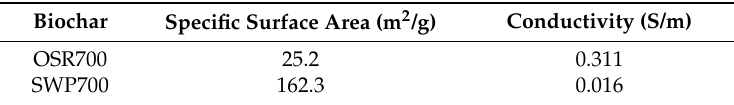
Table 1. Physical properties of OSR700 and SWP 700 biochars. Biochar Specific Surface Area (m 2 /g) Conductivity (S/m) OSR700 25.2 0.311 SWP700 162.3